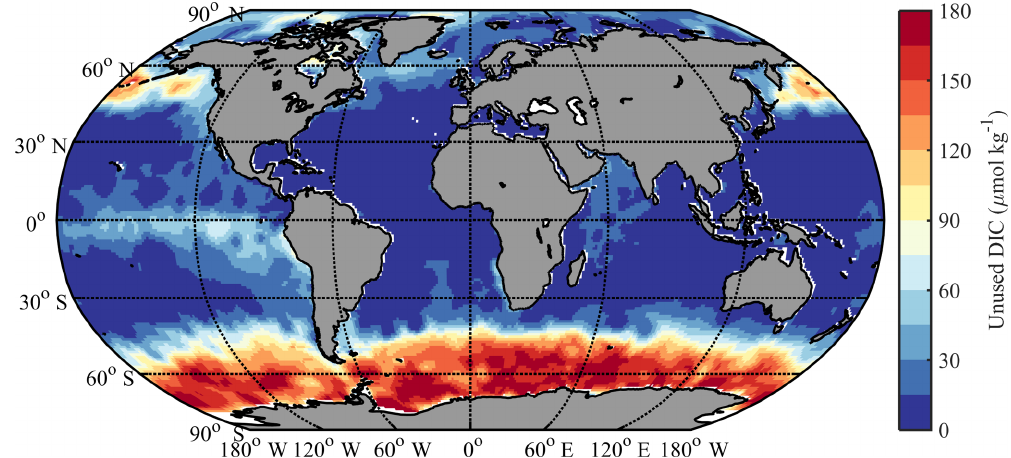
Figure 9. Calculated potential impact of iron limitation on surface DIC. Different colors correspond to different amounts of “unused DIC”, calculated with the Redfield ratio from observed residual